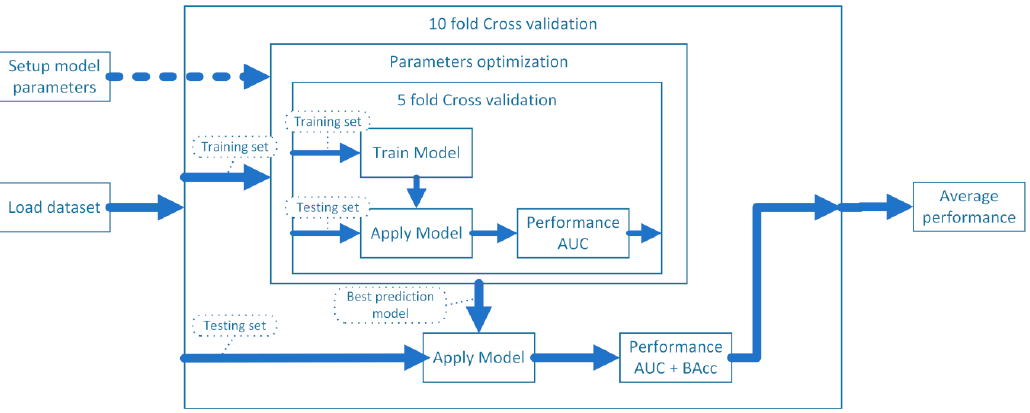
Figure 5. A process of prediction models quality assessment.